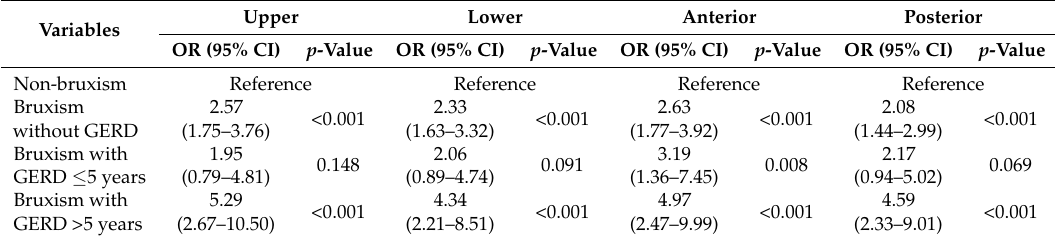
Table 6. Associations among bruxism, GERD, and severe tooth wear for different tooth locations in the univariate